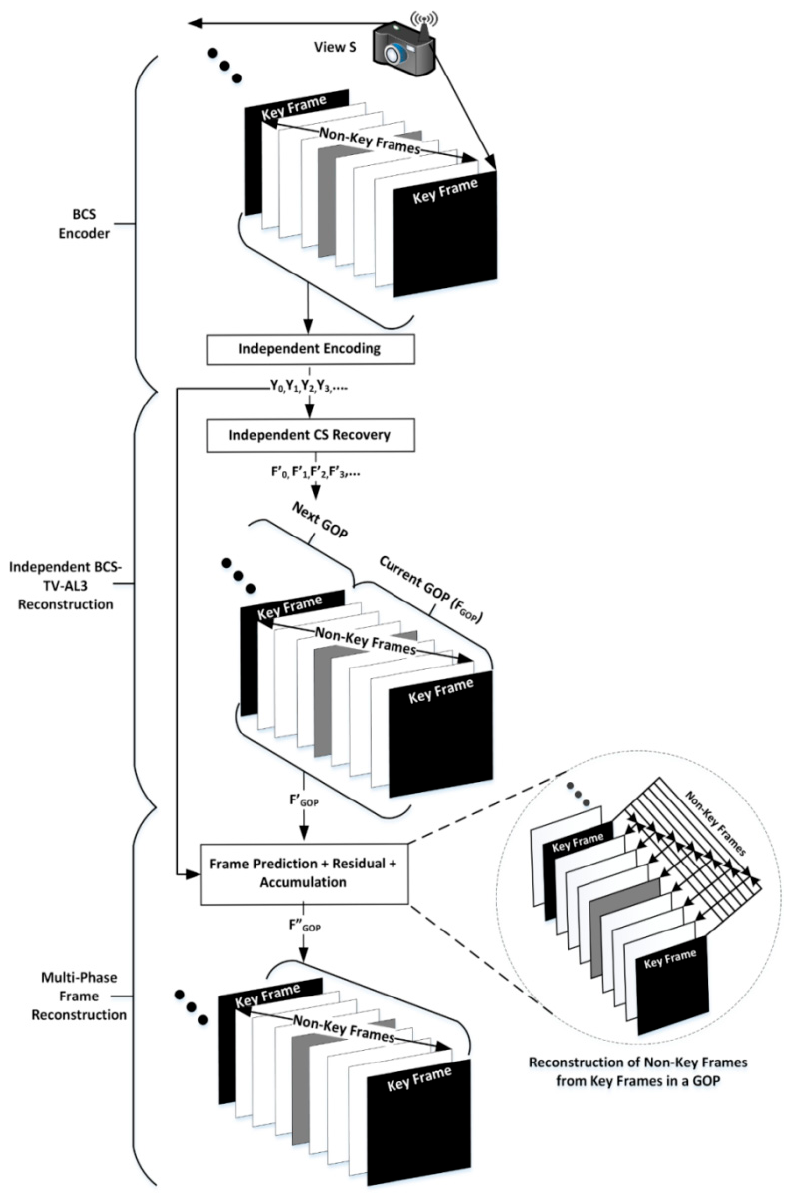
Figure 1. Archetype of the complete system for single-view video coding using the proposed JD (joint